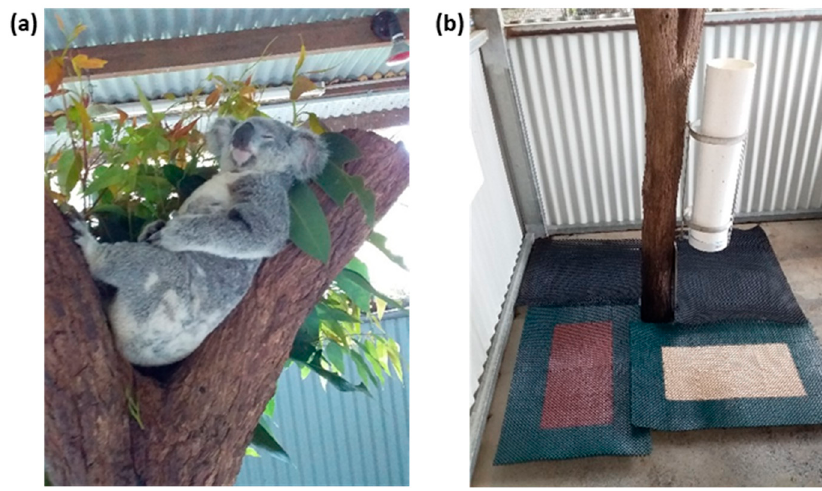
Figure 5. ( a ) Koala Harvey and mats used for faeces collection ( b